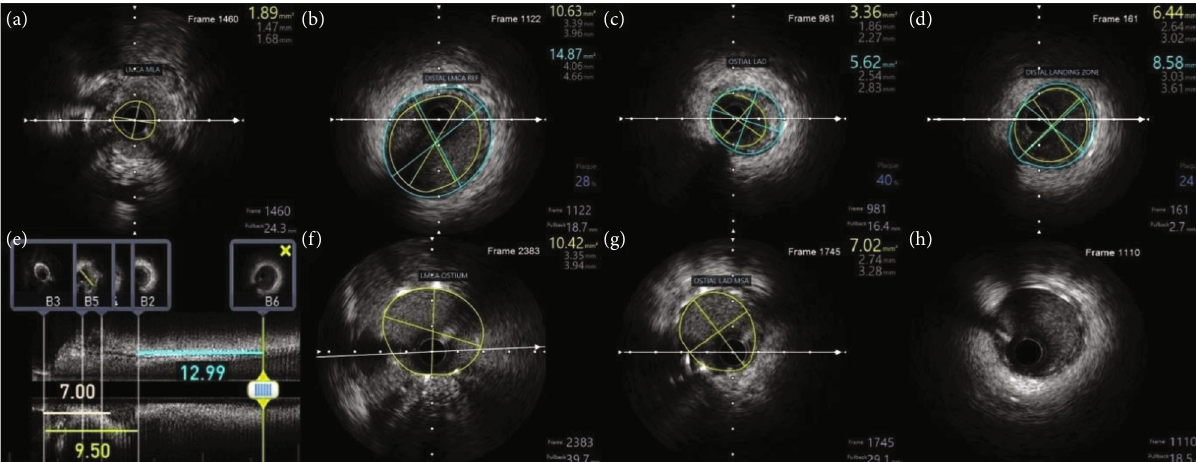
Figure 2: IVUS guidance in initial PCI optimization. Initial IVUS run showed LMCA MLA of 1.89mm 2 (a), and the mean distal LMCA vessel diameter was 4.36 mm (b). MLA of ostial LAD, mean vessel diameter of the distal landing zone, and the total lesion length were 3.36mm 2 , 3.32 mm, and 22.5mm, respectively (c – e). Post IVUS run showed ostial LMCA MSA of 10.42mm 2 (f) and ostial LAD MSA of 7.2mm 2 (g). The distal stent edge was free of edge dissection or malapposition